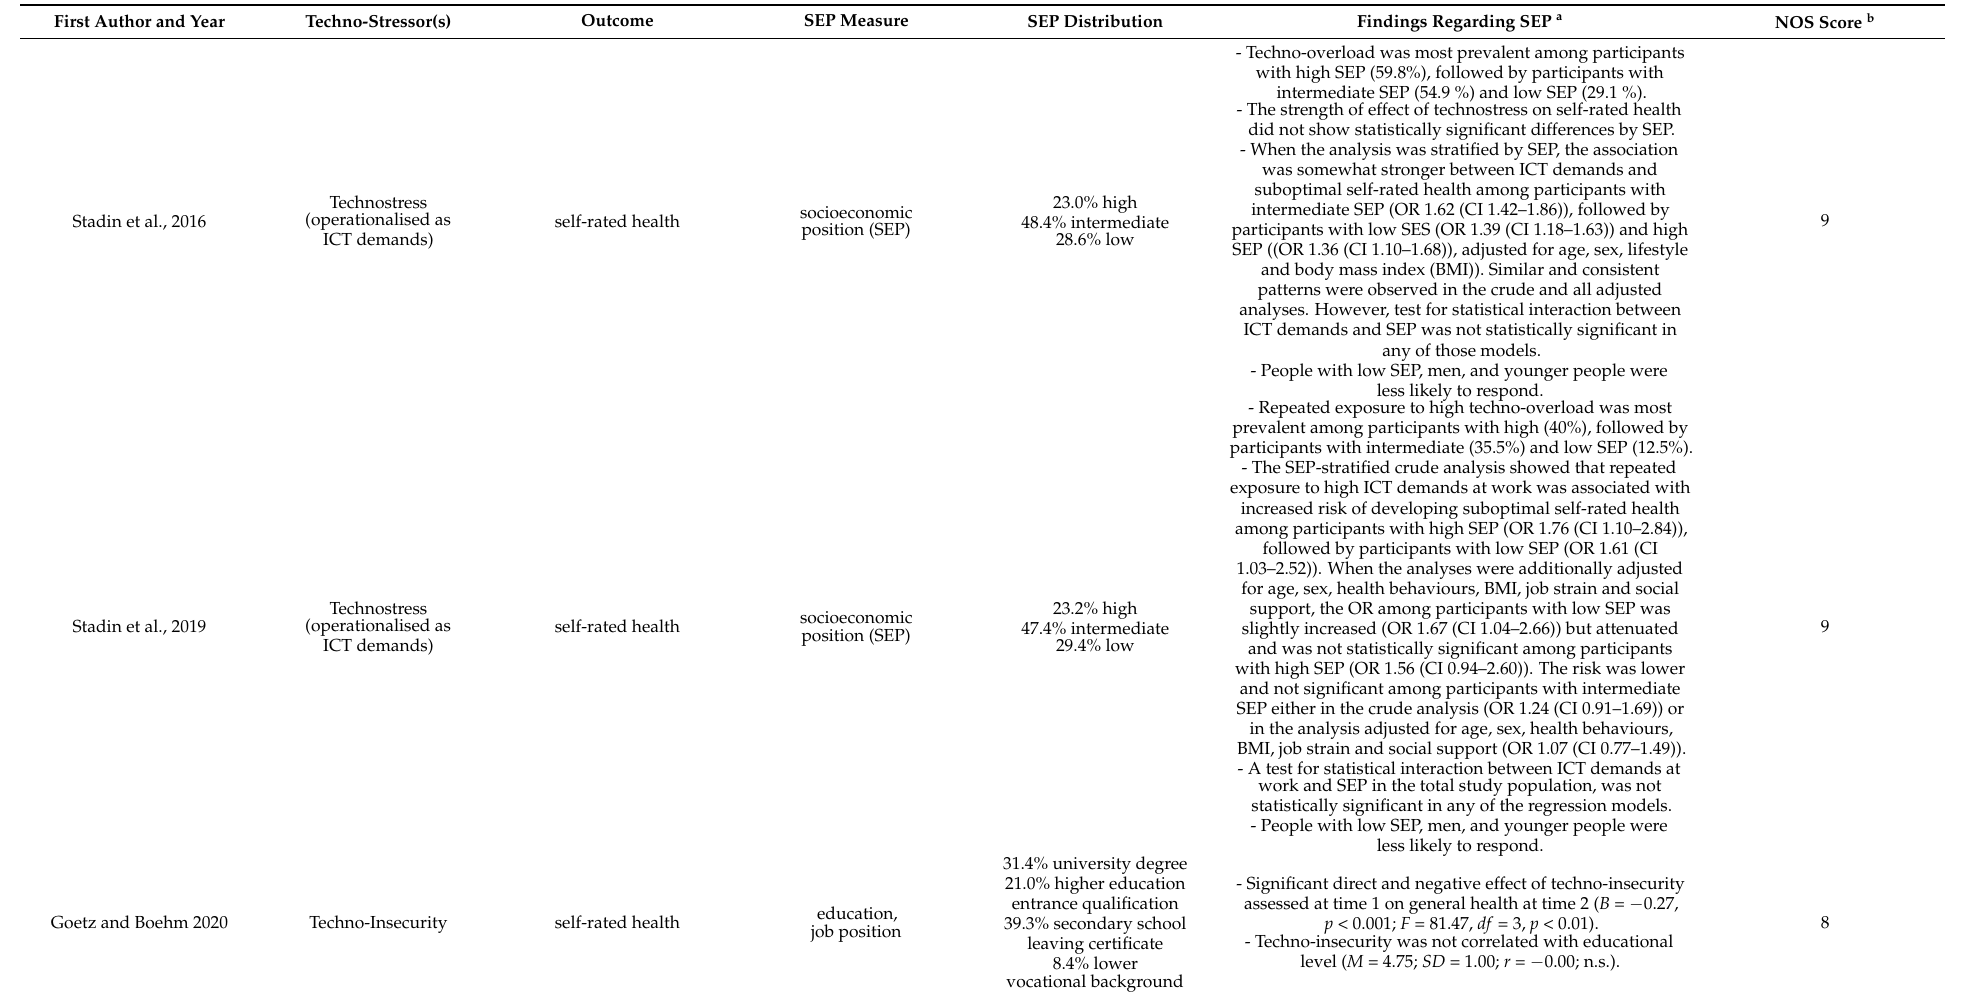
Table 3. Differences by SEP (sorted by NOS